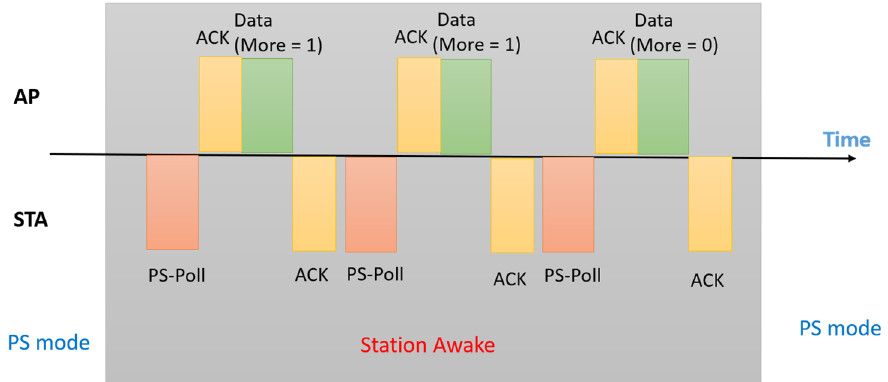
Figure 3. Legacy power management.